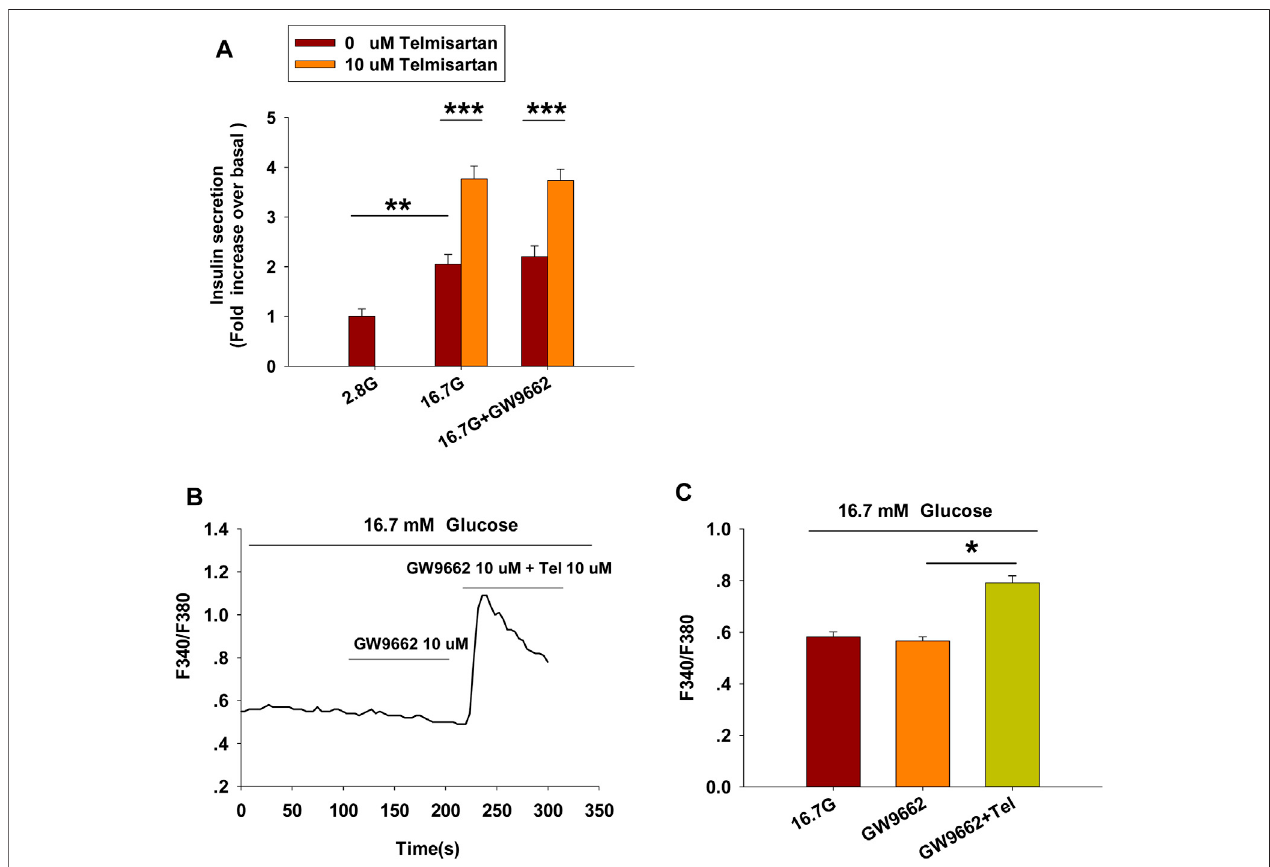
FIGURE 3 | PPAR γ does not participate in the pathway of telmisartan-induced insulin secretion and elevation of [Ca 2+ ] i levels (A) Telmisartan (10 μ M) potentiated glucose-stimulatedinsulinsecretioninthepresenceorabsenceofthePPAR γ inhibitorGW9662(10 μ M)( n (cid:1) 7tubesofislet).Allinsulinsecretionresultsarenormalizedto basal secretion at 2.8 Mm glucose concentration. (B) The trace shows the changes of [Ca 2+ ] i concentration in β -cells treated with GW9662 (10 μ M) alone or in combination with telmisartan (Tel 10 μ M) under 16.7 mM glucose conditions. (C) The average value during 30 s F340/F380 spikes for each test in response to GW9662 alone or in combination with telmisartan under 16.7 mM glucose conditions as indicated ( n (cid:1) 9 cells). The islets or cells compared between the groups in each graph are collected from the same animal. All results are reported as the means ± SEM. In (A) , statistical differences between two groups (with or without telmisartan) were compared using an unpaired two-tailed Student ’ s t test, and difference among three groups without telmisartan were compared using one-way ANOVA and Student-Newman-Keuls method post hoc analysis. In (C) , difference among three groups was determined by one-way ANOVA and Tukey Test post hoc analysis. * p < 0.05, ** p < 0.01, *** p <